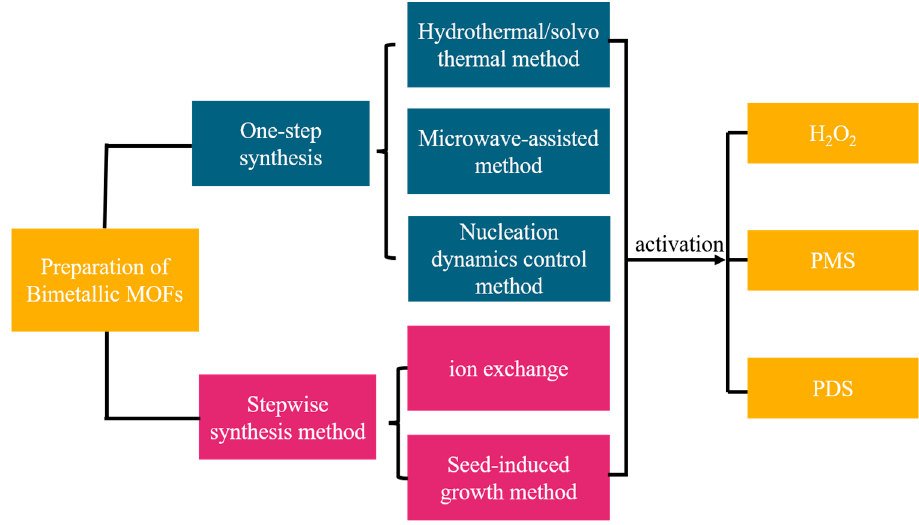
Figure 1. Research fl owchart .